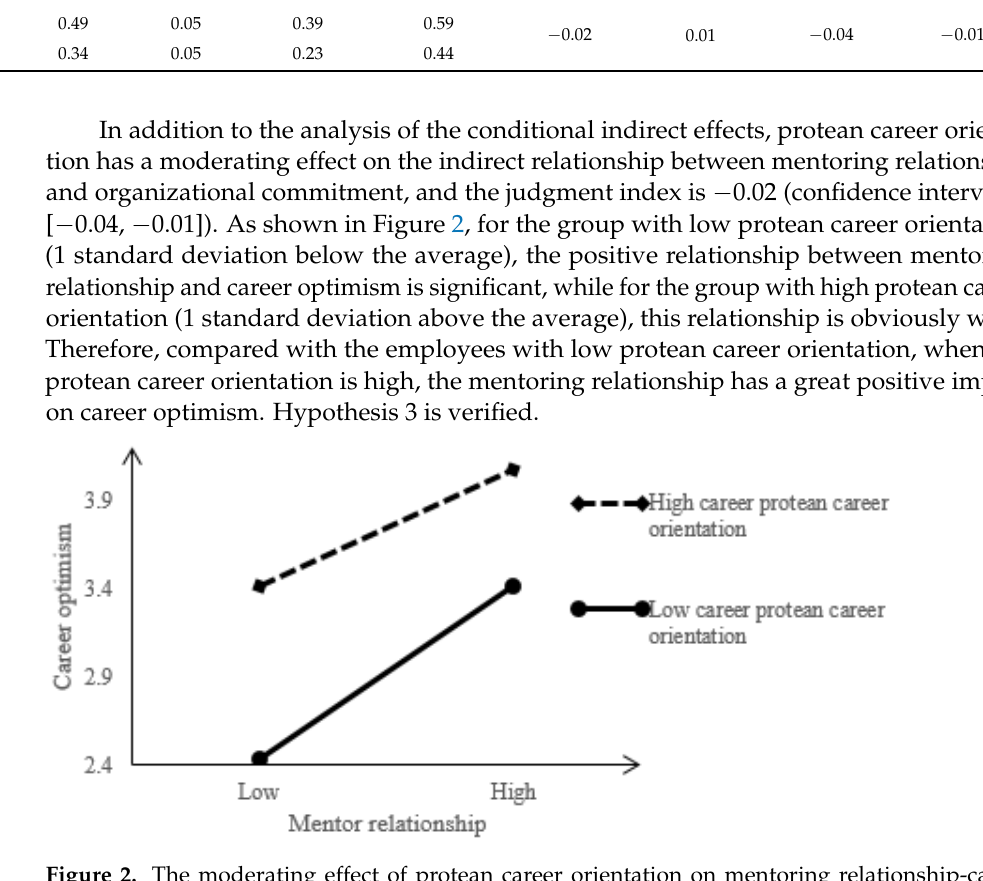
Figure 2. The moderating effect of protean career orientation on mentoring relationship-career optimism.